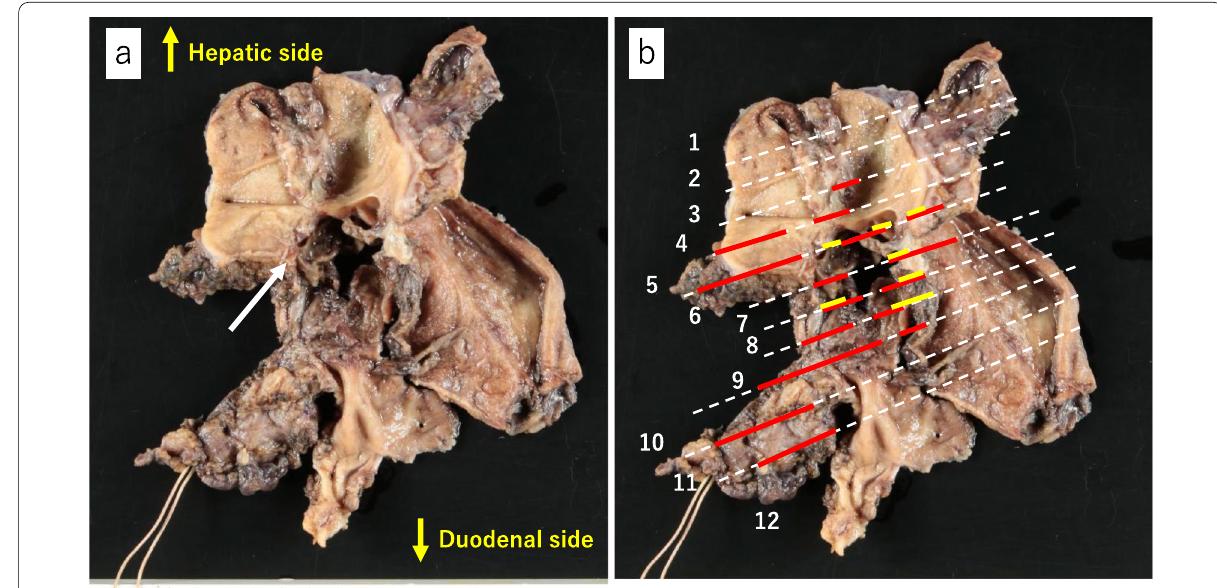
Fig. 4 Macroscopic findings of the resected specimen of extrahepatic bile duct. a Suspected bleeding site with blood clot, severe inflammation, and existence of embolic material (solid white arrow). b A white dotted line with serial number is secant line for pathological examinations. Red lines indicate hemorrhagic area, and a yellow line indicates carcinoma